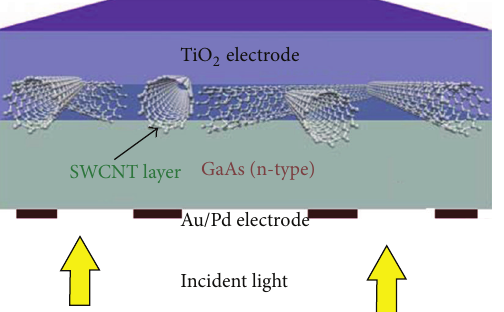
Figure 1: The heterojunction structure of the hybrid SWCNT/GaAs solar cell.